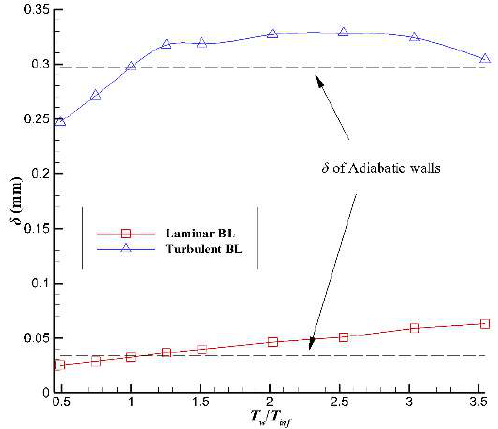
Figure 18. The displacement thickness of boundary layer.